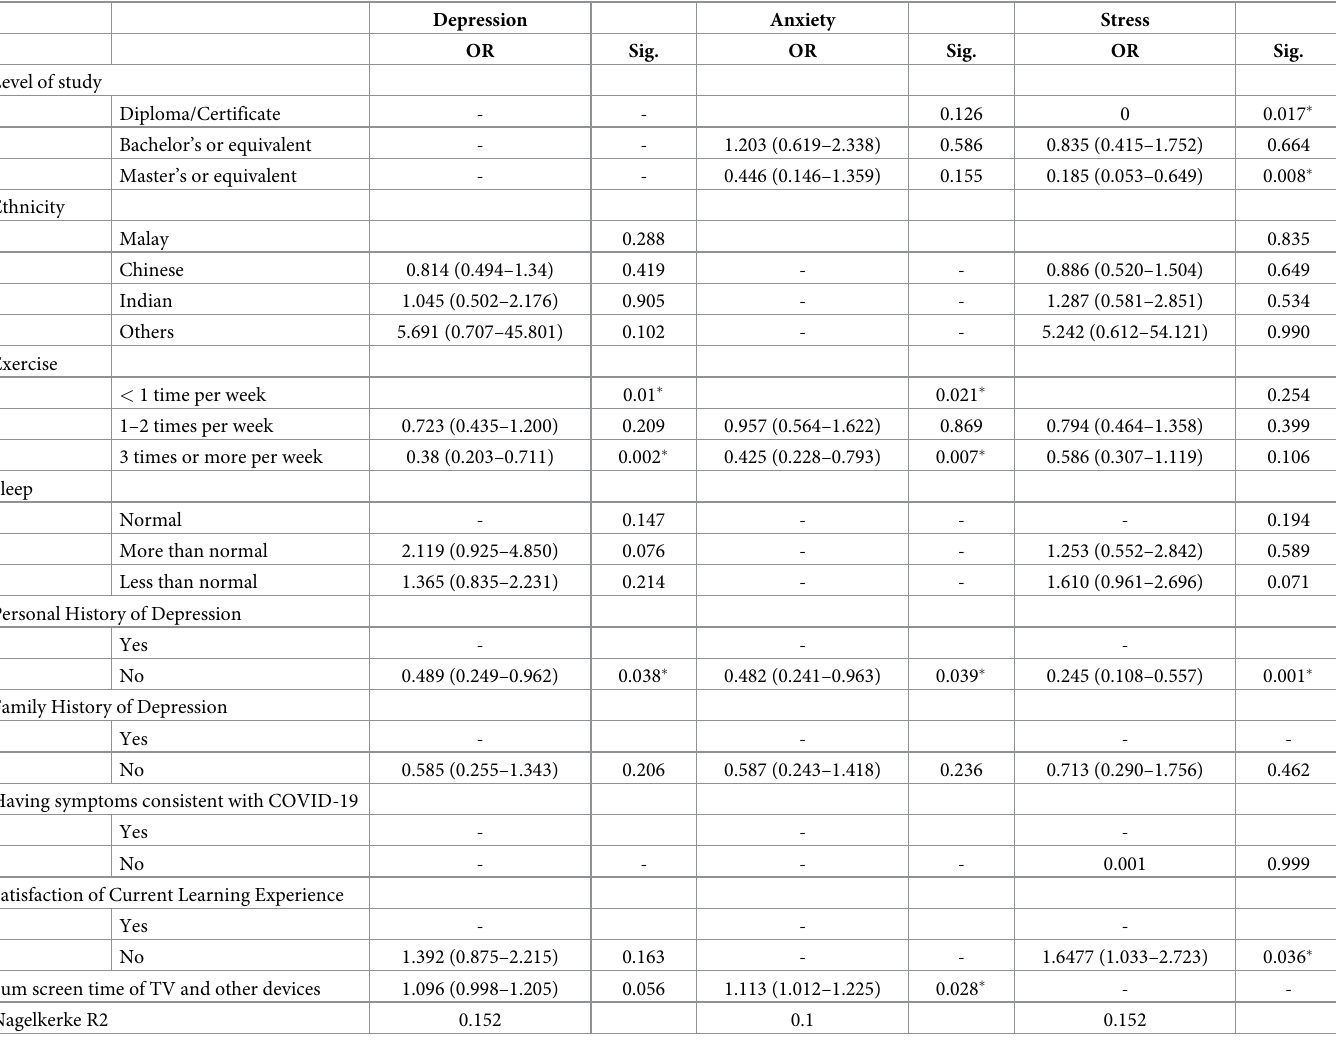
Table 3. Multivariable logistic regression analysis predicting depression, anxiety, and stress among university students who were studying in